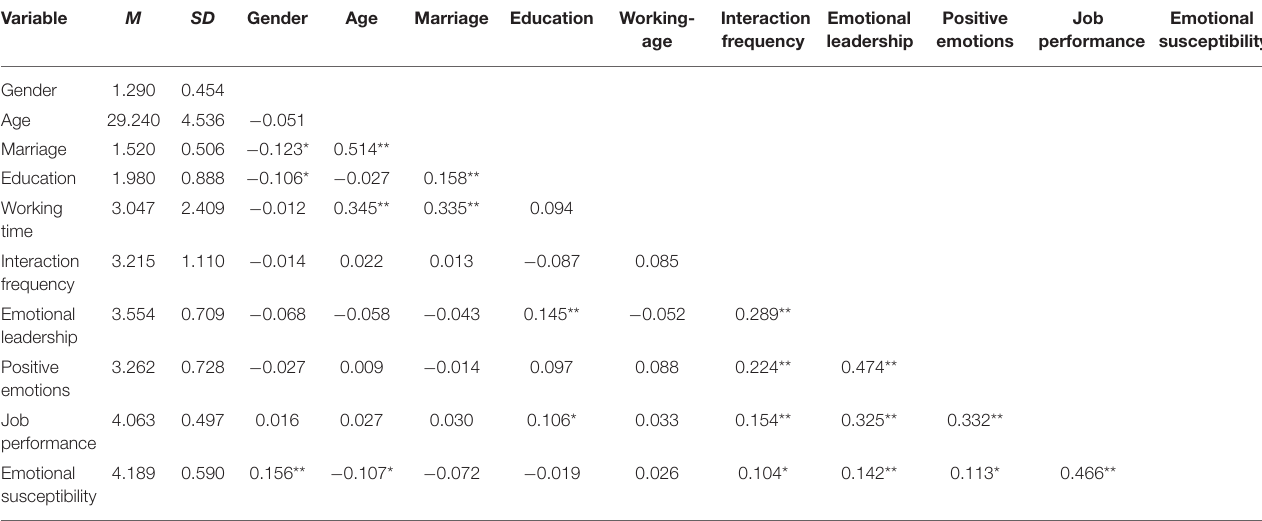
TABLE 1 | Correlation coefficient. Variable M SD Gender Age Marriage Education Working-